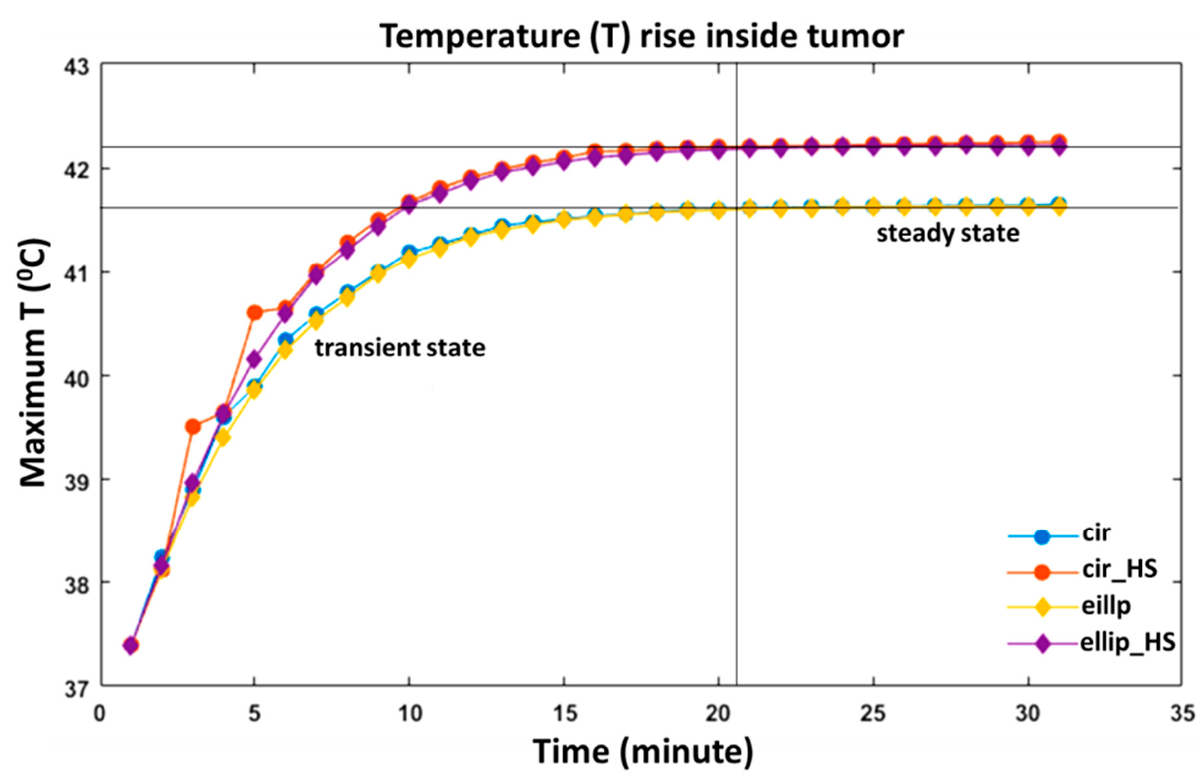
Figure 9. Maximum temperature (T max ) obtained in tumor TV with respect to RF exposure time with deposited RF power (SAR 10g ) calculated from targeted RF heating optimization. For all 16LD ThermalMR RF applicators, T max of the tumor TV reached a steady state after ~20.5 min. The 16LD cir and 16LD ellip yielded a steady state T max ~41.7 ◦ C and the horse-shoe 16LD cir_HS and 16LD ellip_HS achieved a steady state T max ~42.3 ◦